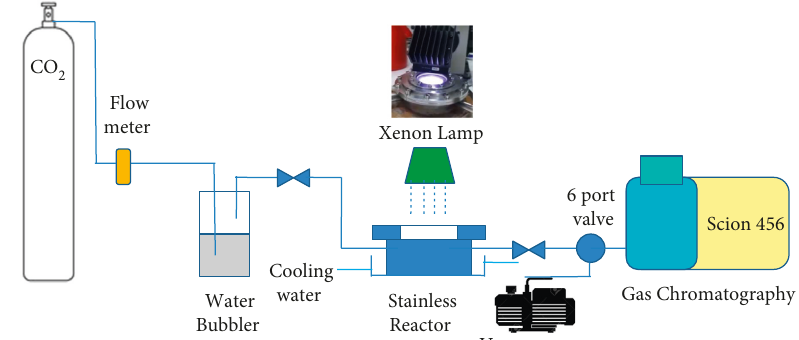
Figure 1: Scheme of the photocatalytic reactor used in this work.